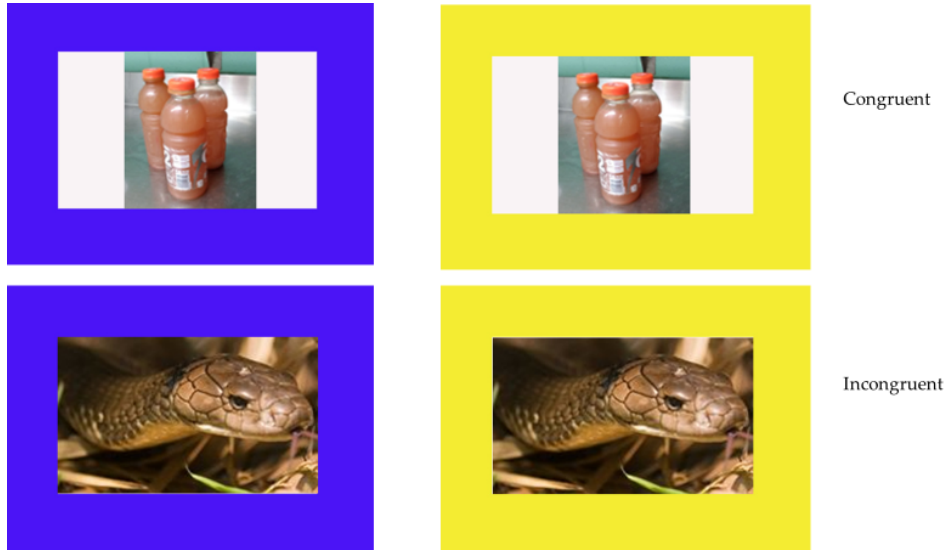
Figure 2. Example of Phase Three trials. Top row shows a congruent trial and bottom row shows an example incongruent trial. The blue border was always correct.